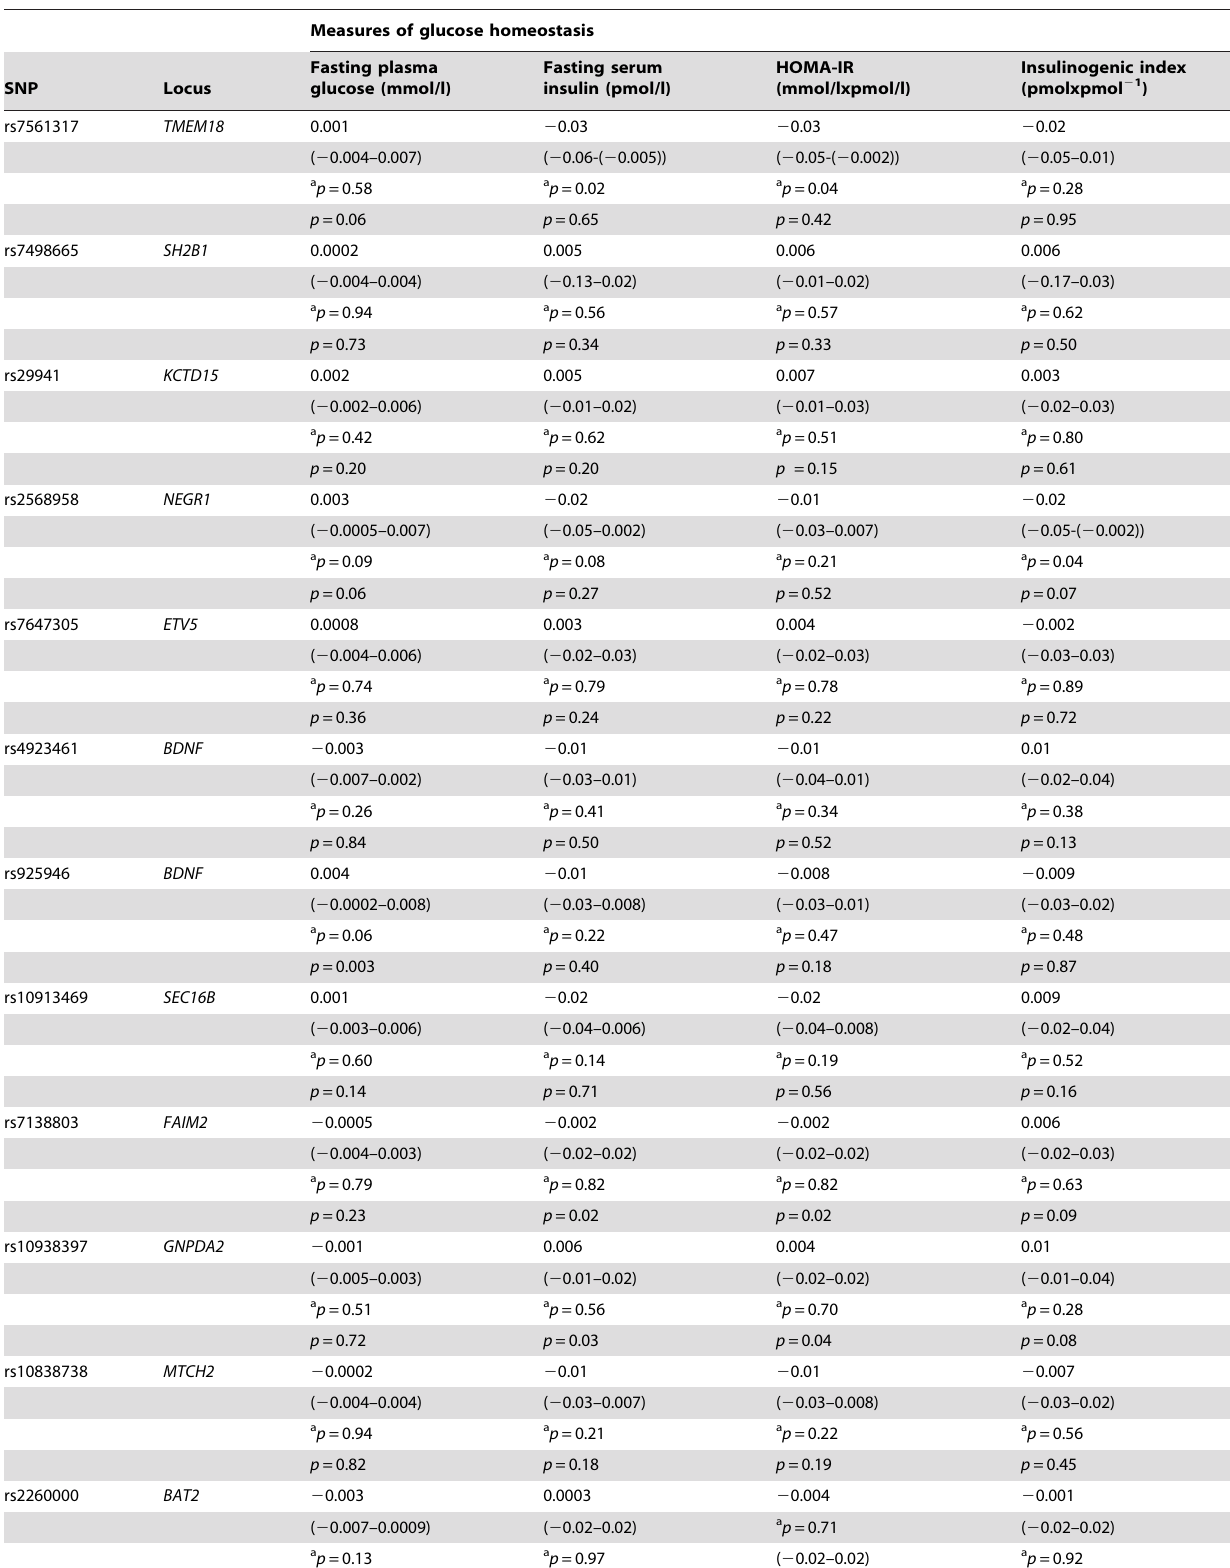
Table 4. Effects sizes of the obesity risk alleles on measures of glucose homeostasis, with and without adjustments for BMI in the population-based Inter99